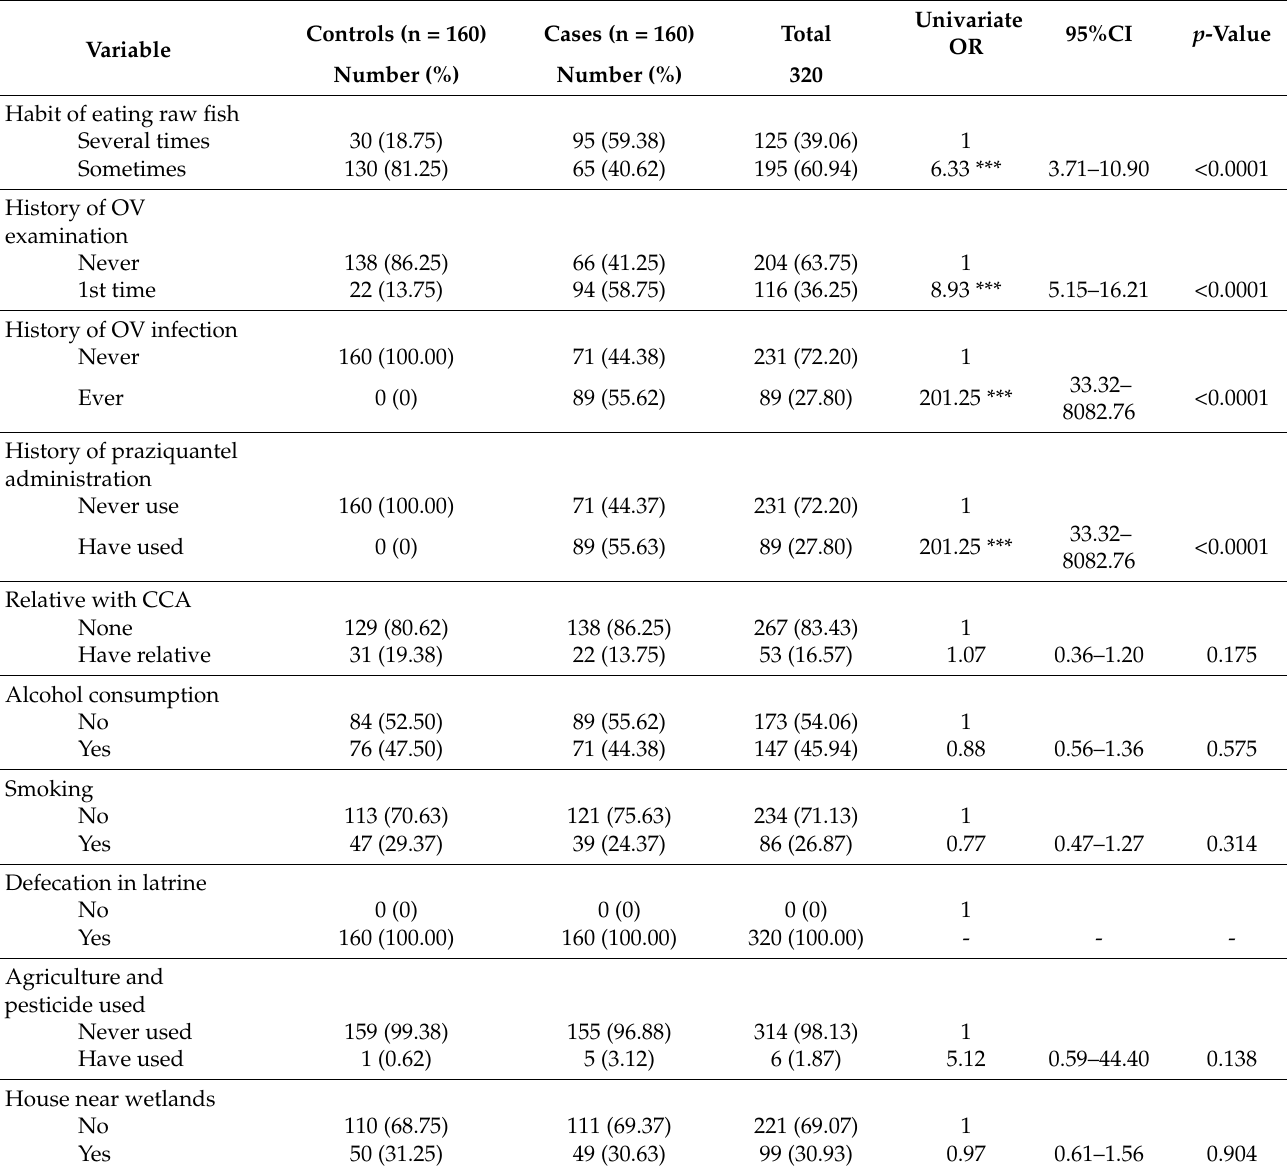
Table 2. Behavior factors associated with O. viverrini infection in Sakon Nakhon province, northeast- ern